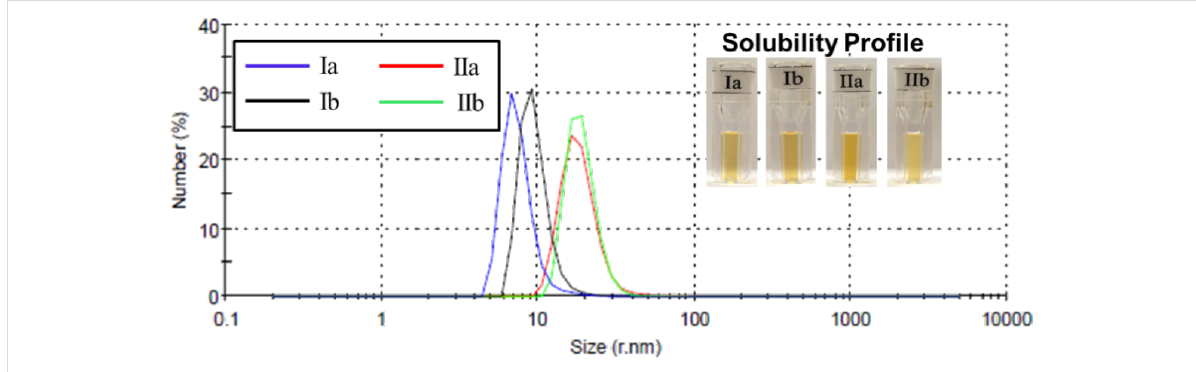
Figure 4: Histogram analyses of the particle size distribution by number, and solubility profile in water at 0.1 mg·mL − 1 of fullerene–steroid derivatives Ia,b and IIa,b .